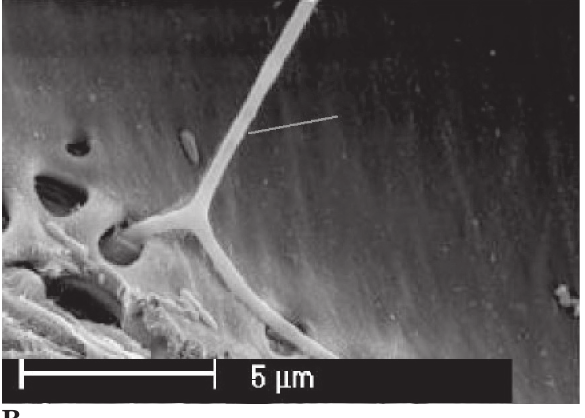
Fig. 4. SEM of inoculated cane segments. A. Turgid hy- phae of E. lata (arrows) in xylem vessel adjacent to pith parenchyma in cane segment inoculated with E. lata alone. B. Turgid hyphae of T. harzianum (arrow) in pit of xylem vessel in cane segment inoculated with T. har- zianum alone. C. Flaccid hyphae in co-inoculated cane